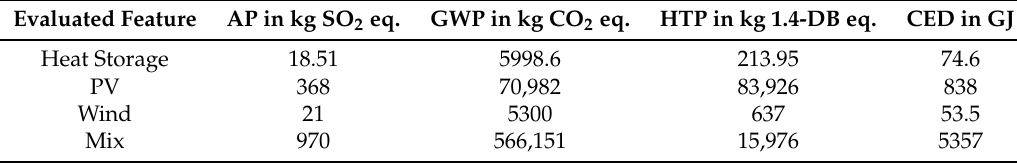
Table 9. Comparison between storage and source of electricity.